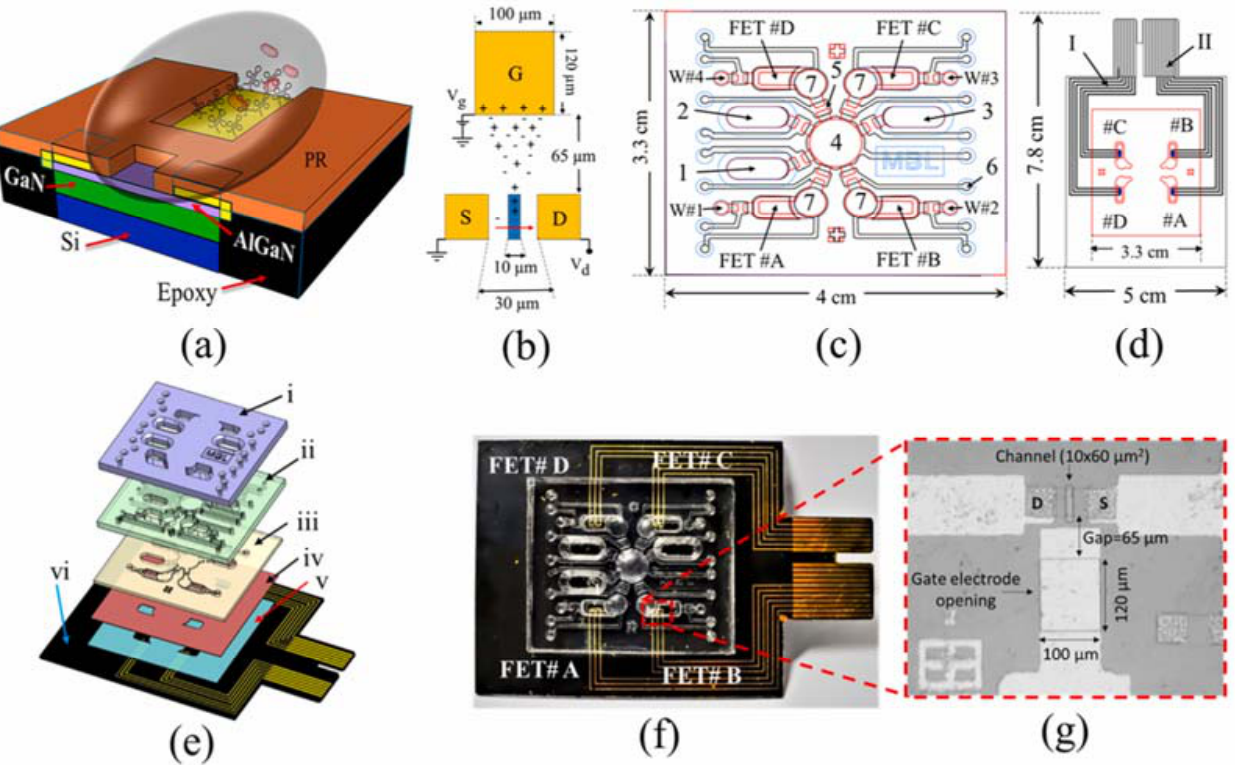
Figure 1. Integrated sensor design. ( a ) Side view of the sensor showing semiconductor packaging and materials (PR = photoresist). ( b ) Design of the source (S), drain (D), and gate (G) sensor terminals. Vg = gate voltage and Vd = drain voltage. ( c ) Microfluidic chip with the three reservoirs (1; 2; 3) to store the samples and reagents needed for detection, (4) micropump, (W1, 2, 3, and 4) waste collection chambers, (5) micropump fluid contact, (6) air inlet, and (#7) micromixers. Four field effect transistors were used. ( d ) Shows the position of the FET sensor arrays. ( e ) Layers of the microfluidic chip: top reagent reservoir (i), pneumatic control layer (ii), liquid flow channel layer (iii), thin PDMS layer (iv), double-sided tape (v), and FET-embedded epoxy substrate (vi). ( f ) Photograph of the integrated sensor. ( g ) Zoom view of the FET area. Reprint by permission from Elsevier.